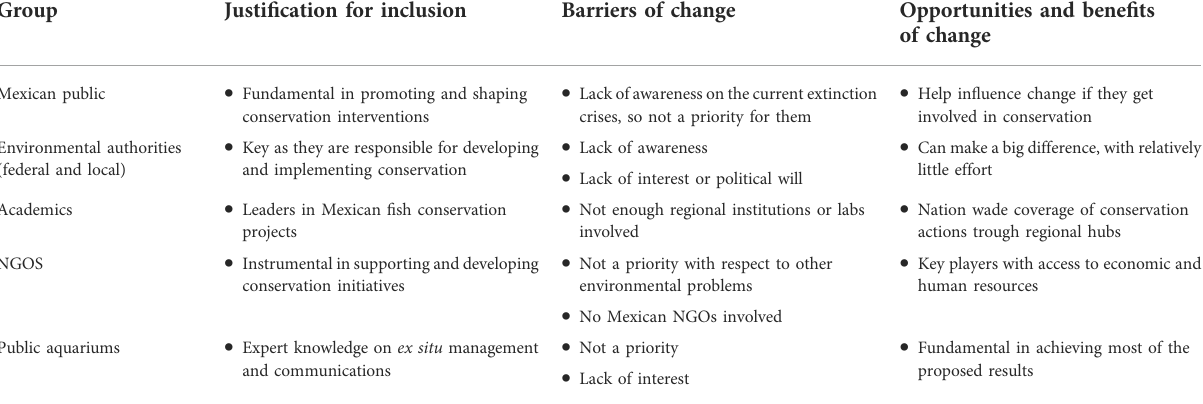
TABLE 1 Key stakeholder groups considered in the theory of change. Group Justi fi cation for inclusion